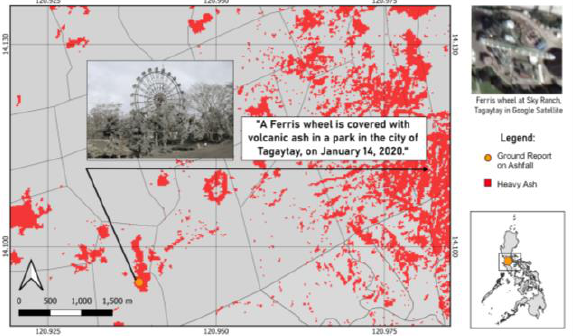
Figure 6. Validating the potential ashfall in Tagaytay City with ground reports